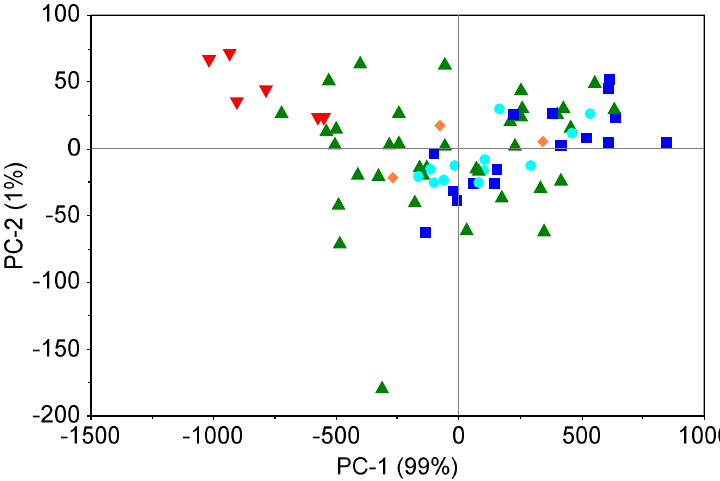
Figure 5. Score plot of the PCA based on soil spectral data. The colours represent PAH content. Blue: